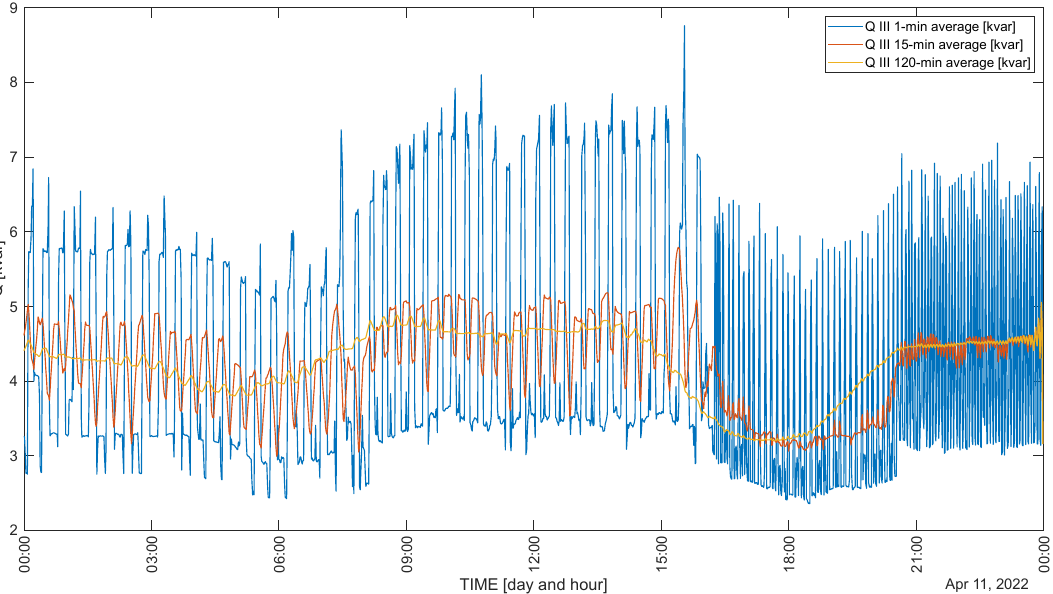
Figure 12. Three-phase reactive power as a function of time on a representative day of the 1st stage. Table 4. Electricity consumption in successive stages of the